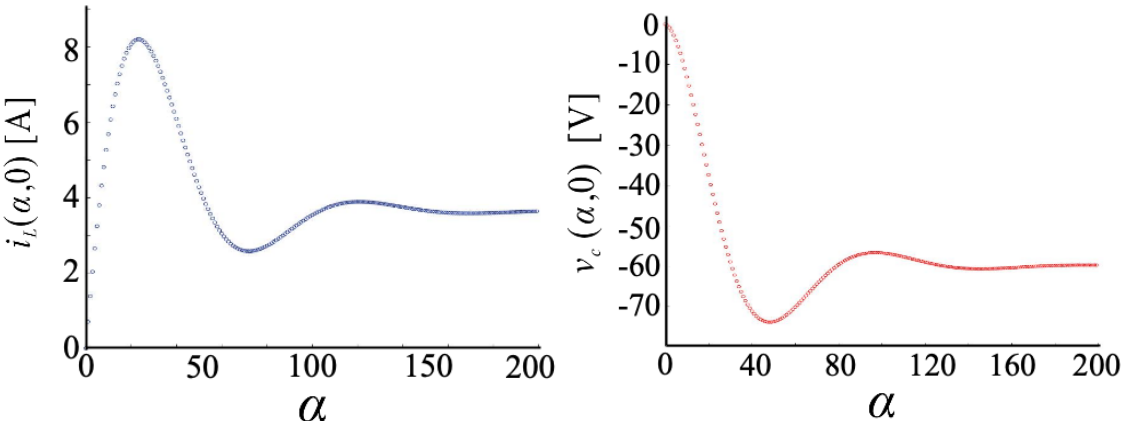
Figure 6. Graph of the ICCV at the beginning the α -th switching period from S 2 parameters through analytical Equations (33) and (34).